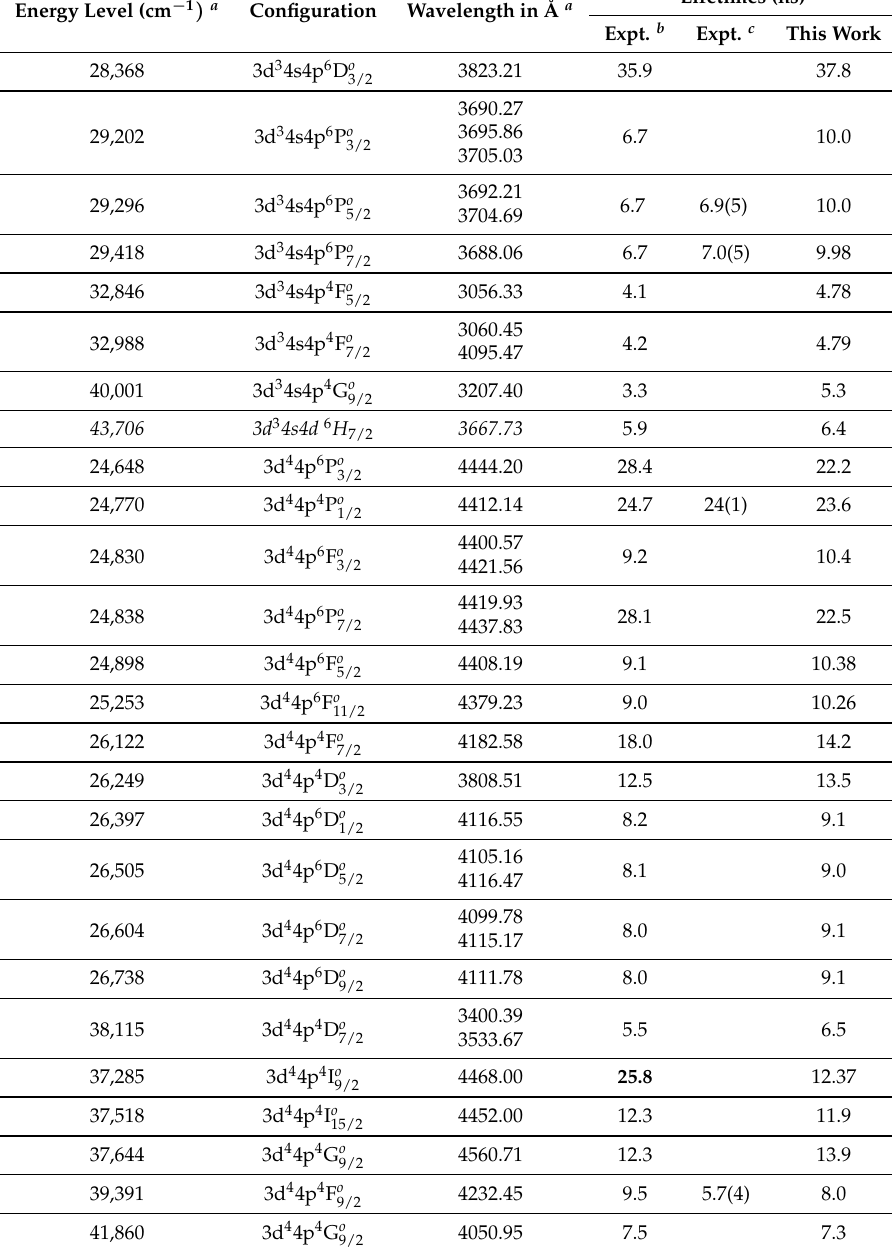
Table 1. Lifetimes of upper levels corresponding to spectral lines with the Stark broadening parameters calculated in this